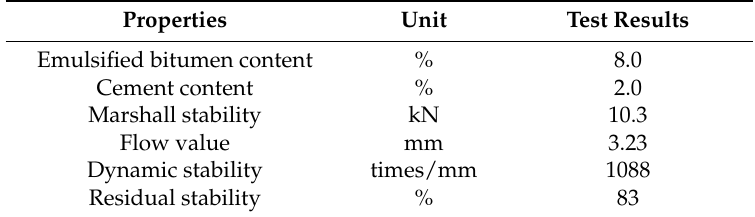
Table 7. Properties of cement emulsified asphalt mixture (CEAM).